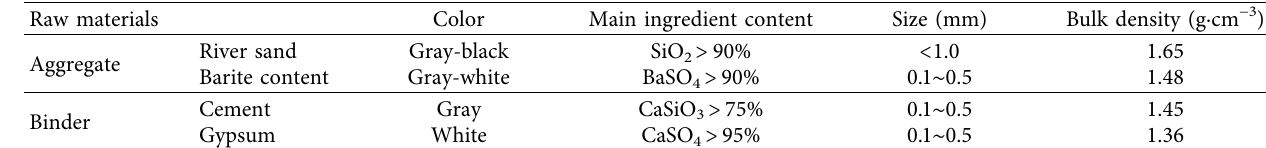
Table 6: Basic parameters of raw